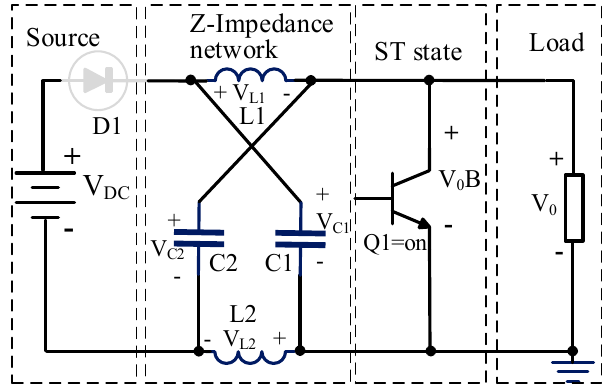
Figure 6. Electrical diagram of Z-source converter in the Non-Shoot-Through (NST) state.